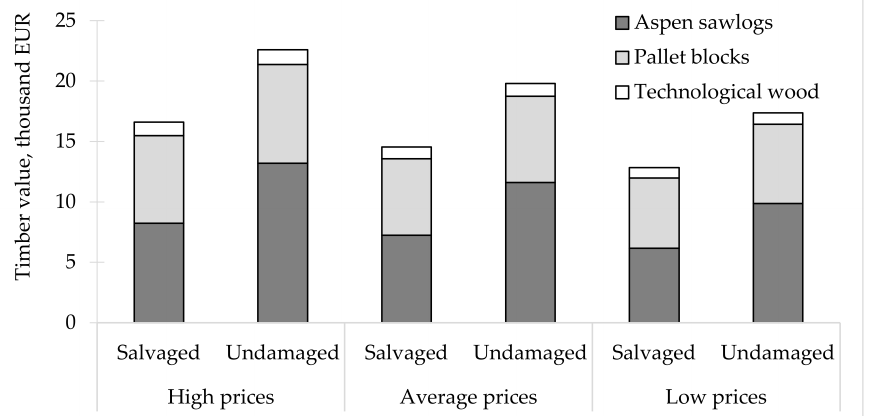
Figure 5. Timber value for salvaged and undamaged timber ( n = 525) according to high (the year 2019), average (mean for 2016–2019), and low (the year 2016)